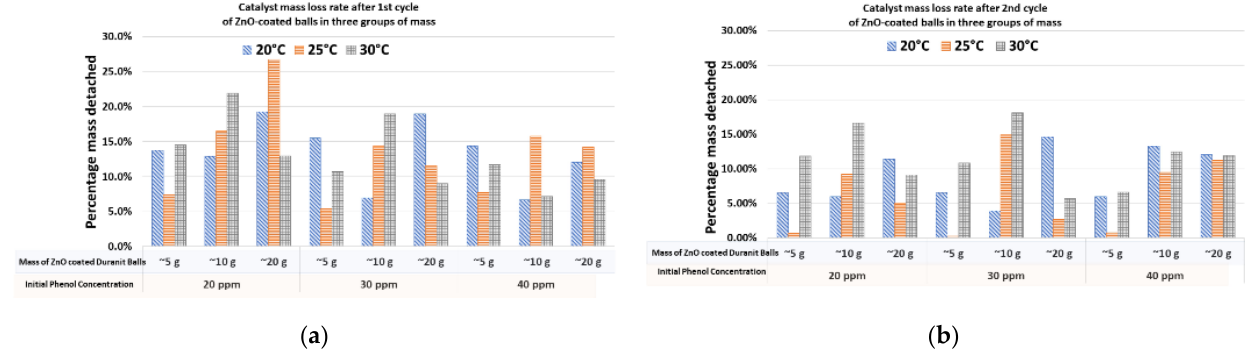
Figure 9. The percentage of ZnO mass detached from Duranit balls after the ( a ) 1st and ( b ) 2nd cycle of photocatalysis.